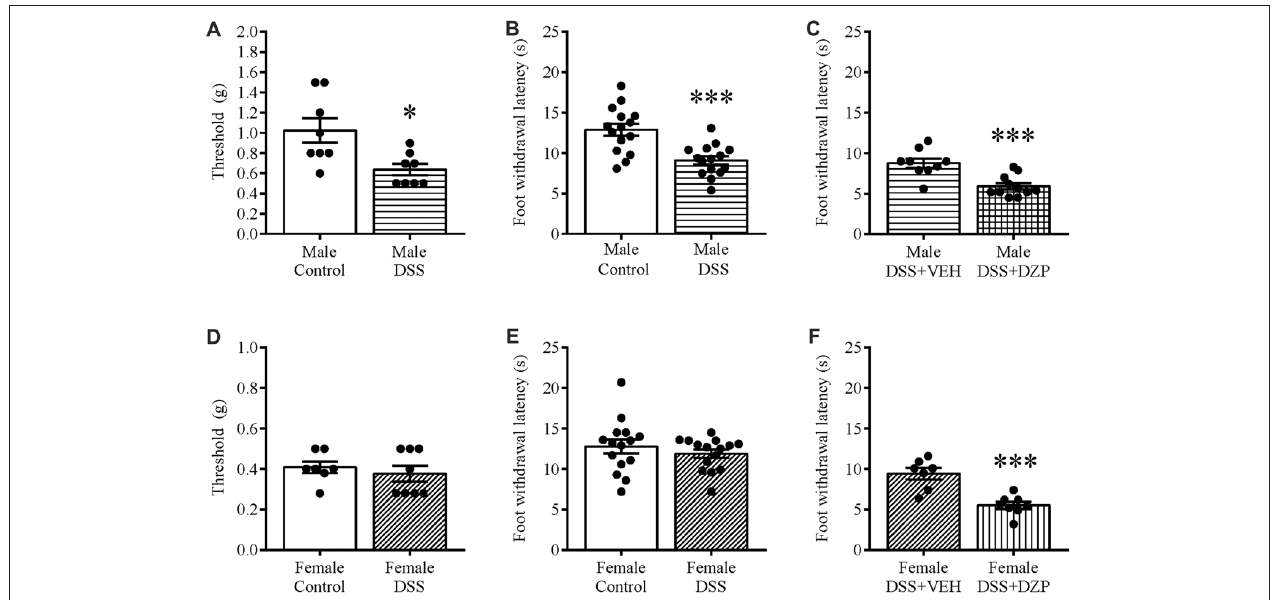
FIGURE 5 | Mechanical and thermal hyperalgesia in DSS colitis: aggravation by DZP. On the morning of D7, separate cohorts of control and DSS-treated mice were tested for mechanical and thermal pain perception by subjecting their paws to calibrated von Frey hairs, or exposing them to the hot plate (52 ◦ C) for a maximum of 30 s respectively. DSS treatment reduced withdrawal thresholds (A) , and the foot withdrawal latency (B) in only males and not females (D,E) . A different set of DSS-treated mice were administered VEH or DZP (ip) 30 min before testing. DZP aggravated hyperalgesia by further reducing the foot withdrawal latency in both males (C) and females (F) . ∗∗∗ P < 0.001, ∗ P < 0.05 vs. control/DSS vehicle